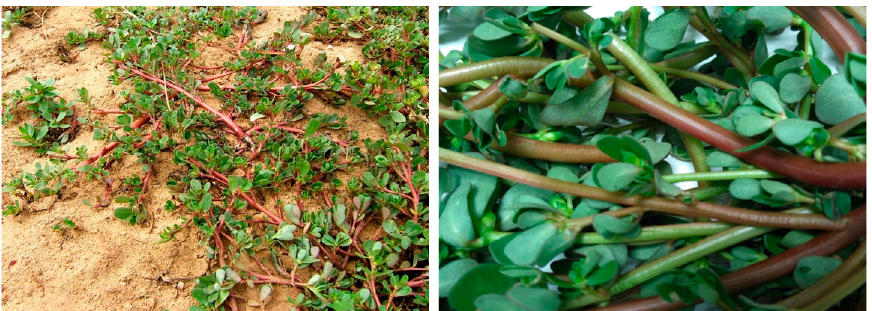
Figure 1. Portulaca oleracea L.